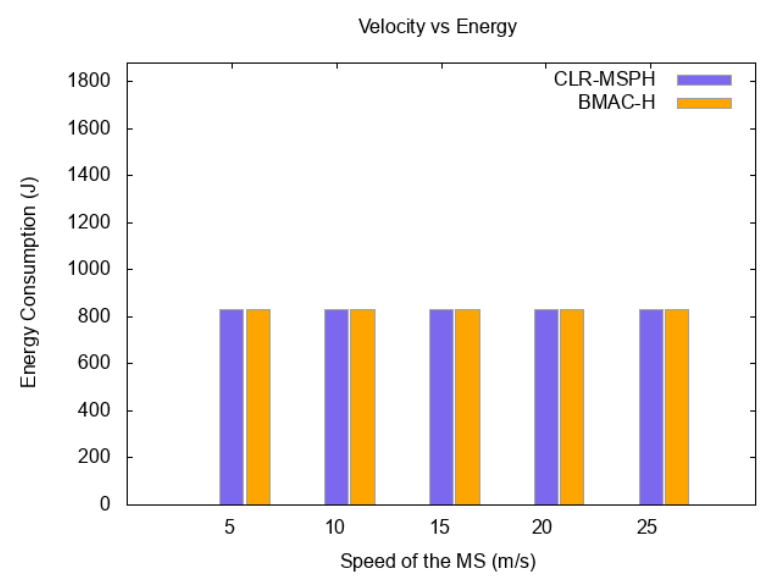
Figure 10. Energy consumed in each protocol with varying the speed of the MS.